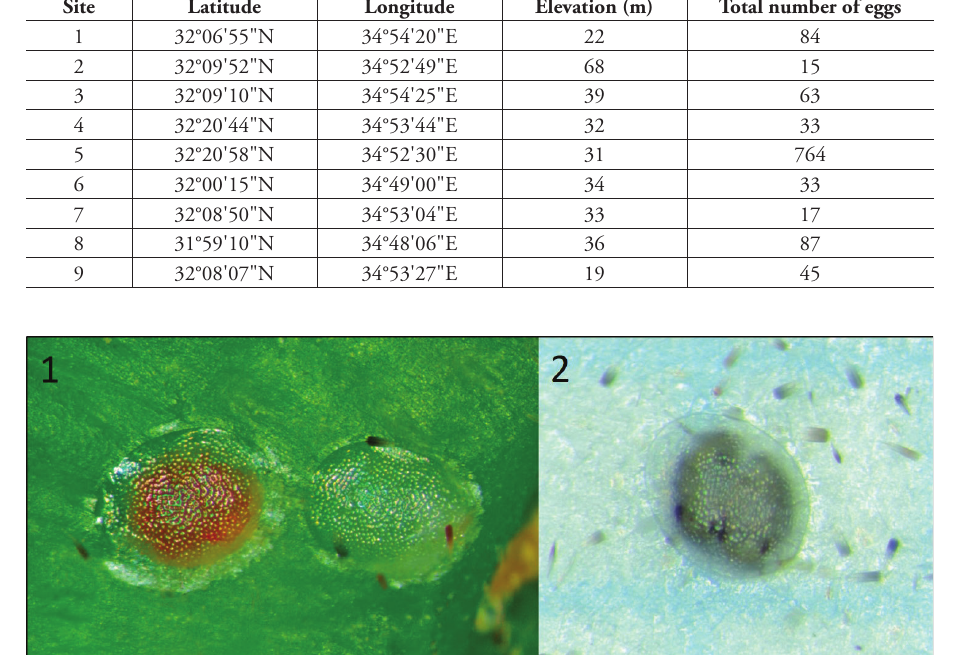
Figure 1–2. Thaumatotibia leucotreta eggs. 1 Unparasitised young (clear white) and mature (red) eggs 2 parasitised by Trichogramma